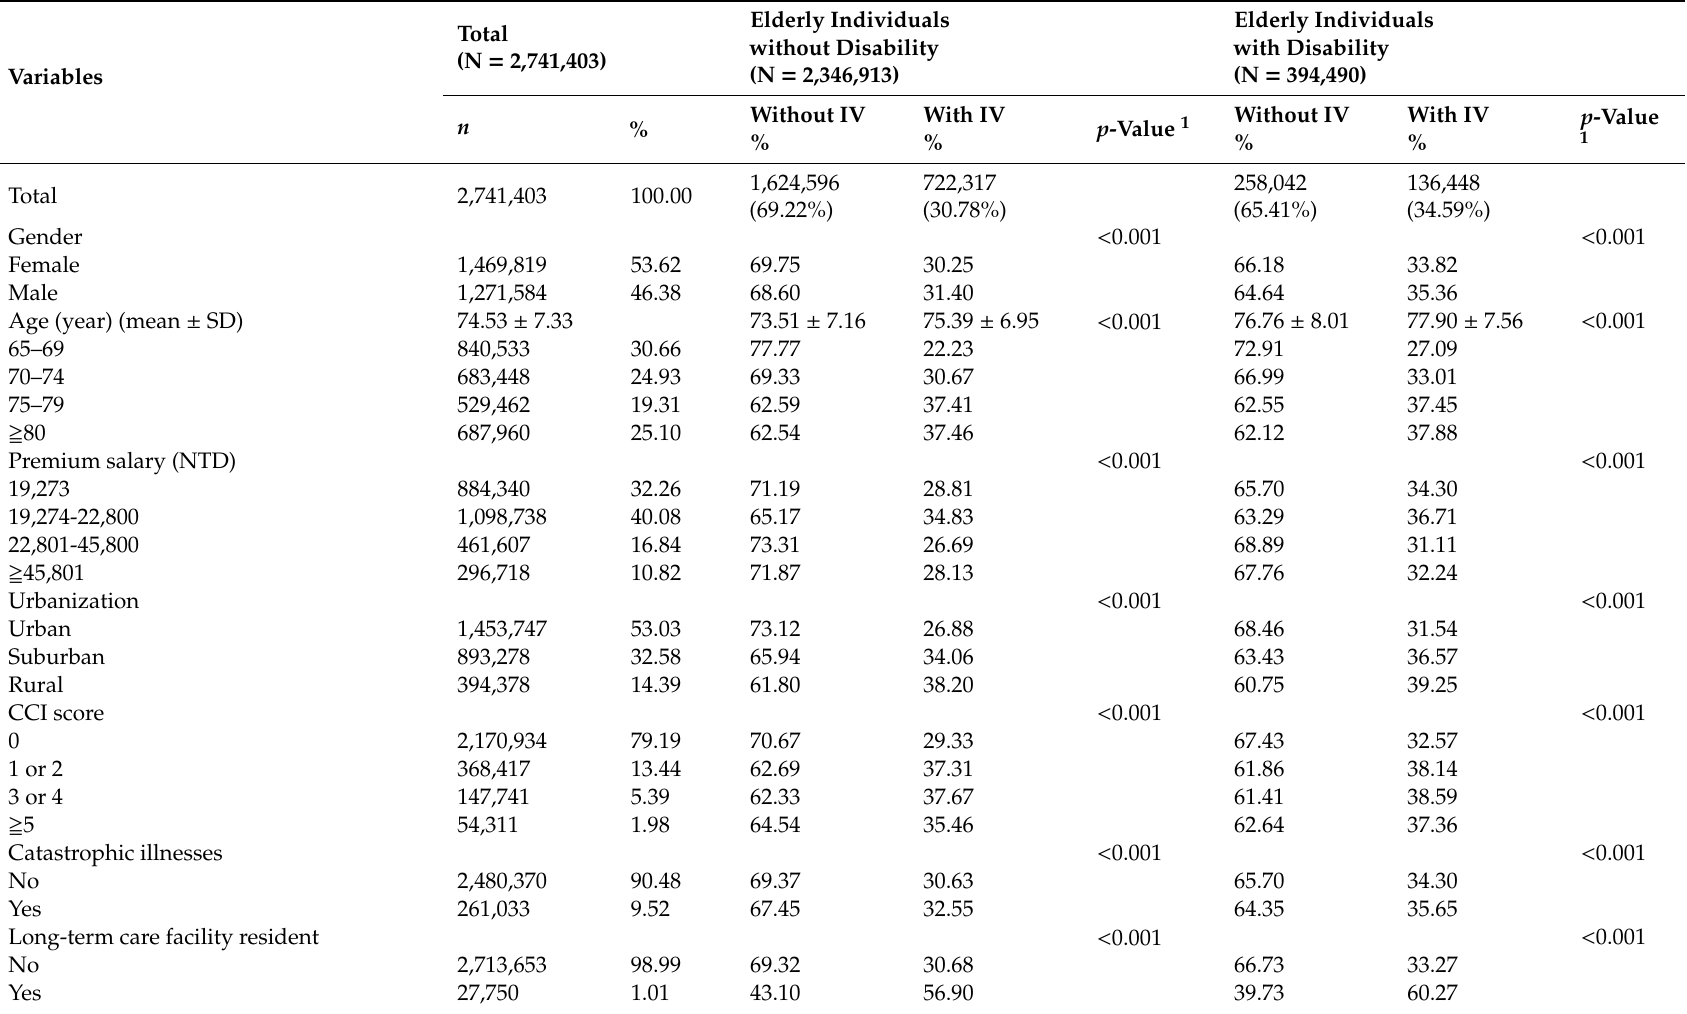
Table 1. Baseline characteristics of all elderly